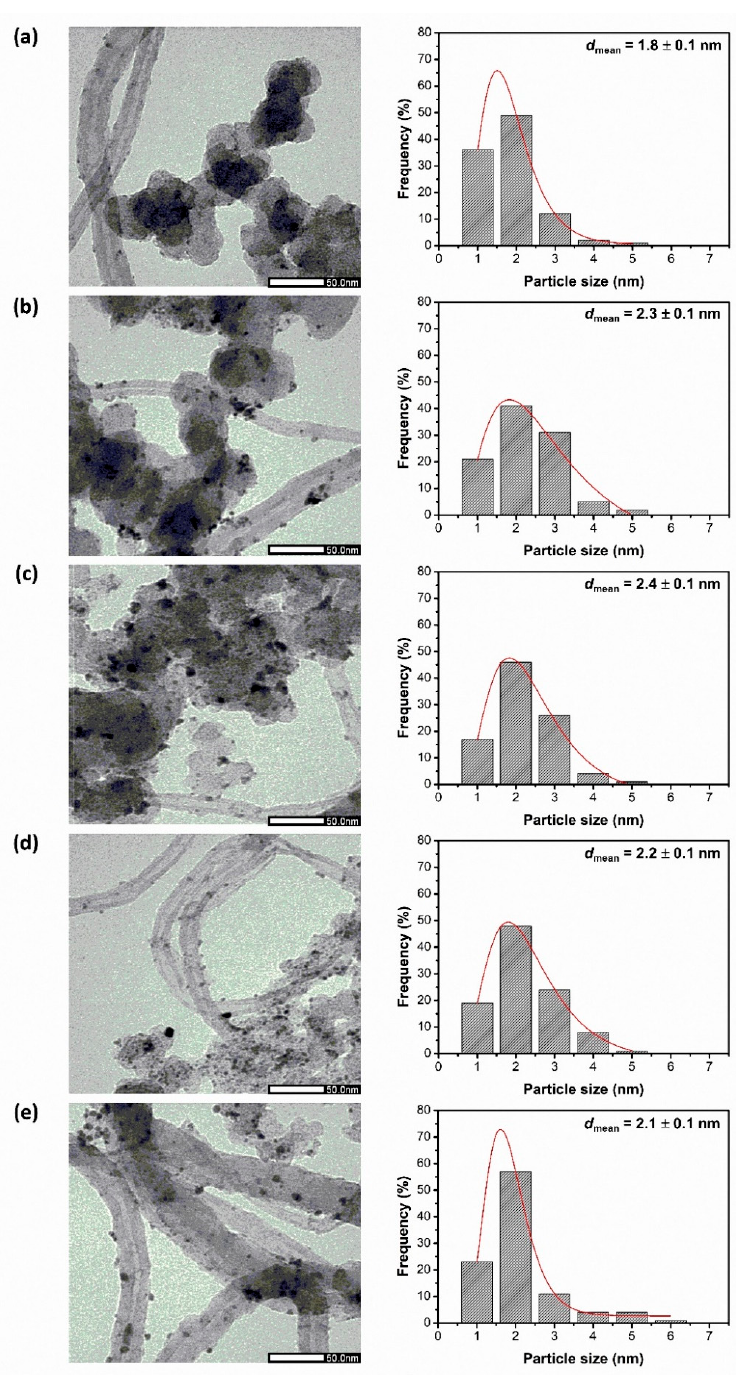
Figure 5. TEM images and particle size distributions of ( a ) PtRu/C 90 MWCNTs 10 , ( b ) PtRu/C 80 MWCNTs 20 , ( c ) PtRu/C 70 MWCNTs 30 , ( d ) PtRu/C 60 MWCNTs 40 , and ( e ) PtRu/C 50 MWCNTs 50 .